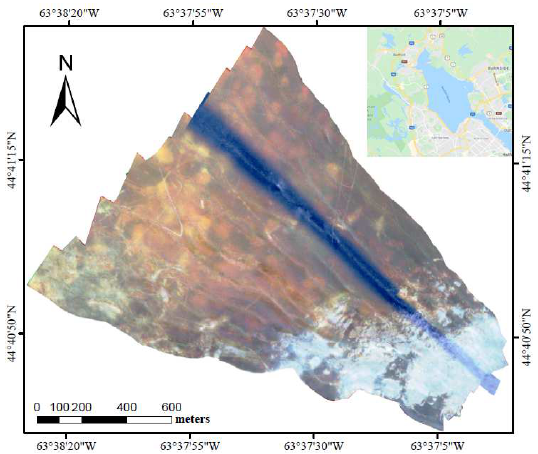
Figure 1. Bedford Basin 2016 Dataset. A pseudocolor is presented from the combination of 100 kHz, 200 kHz and 400 kHz backscatter layers.